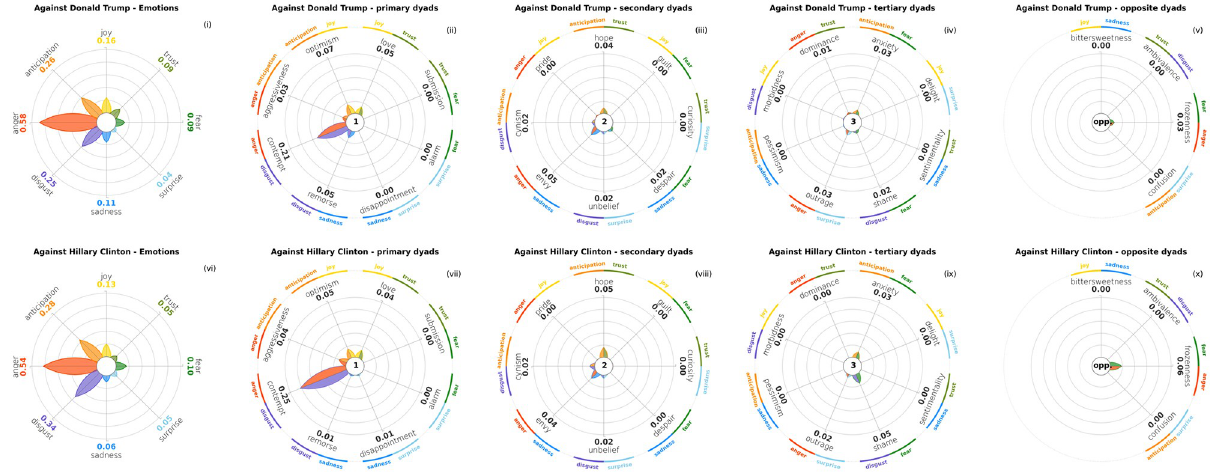
Fig 15. Similarly to Fig 14, here are shown the emotions captured in the tweets against Donald Trump and Hillary Clinton from the 2016 StanceDetection task in SemEval. We see a clear prevalence of negative emotions, particularly Anger and Disgust . This combination is often expressed together, as can be seen from the primary emotions plots (ii and vii), where there is a spike in Contempt .